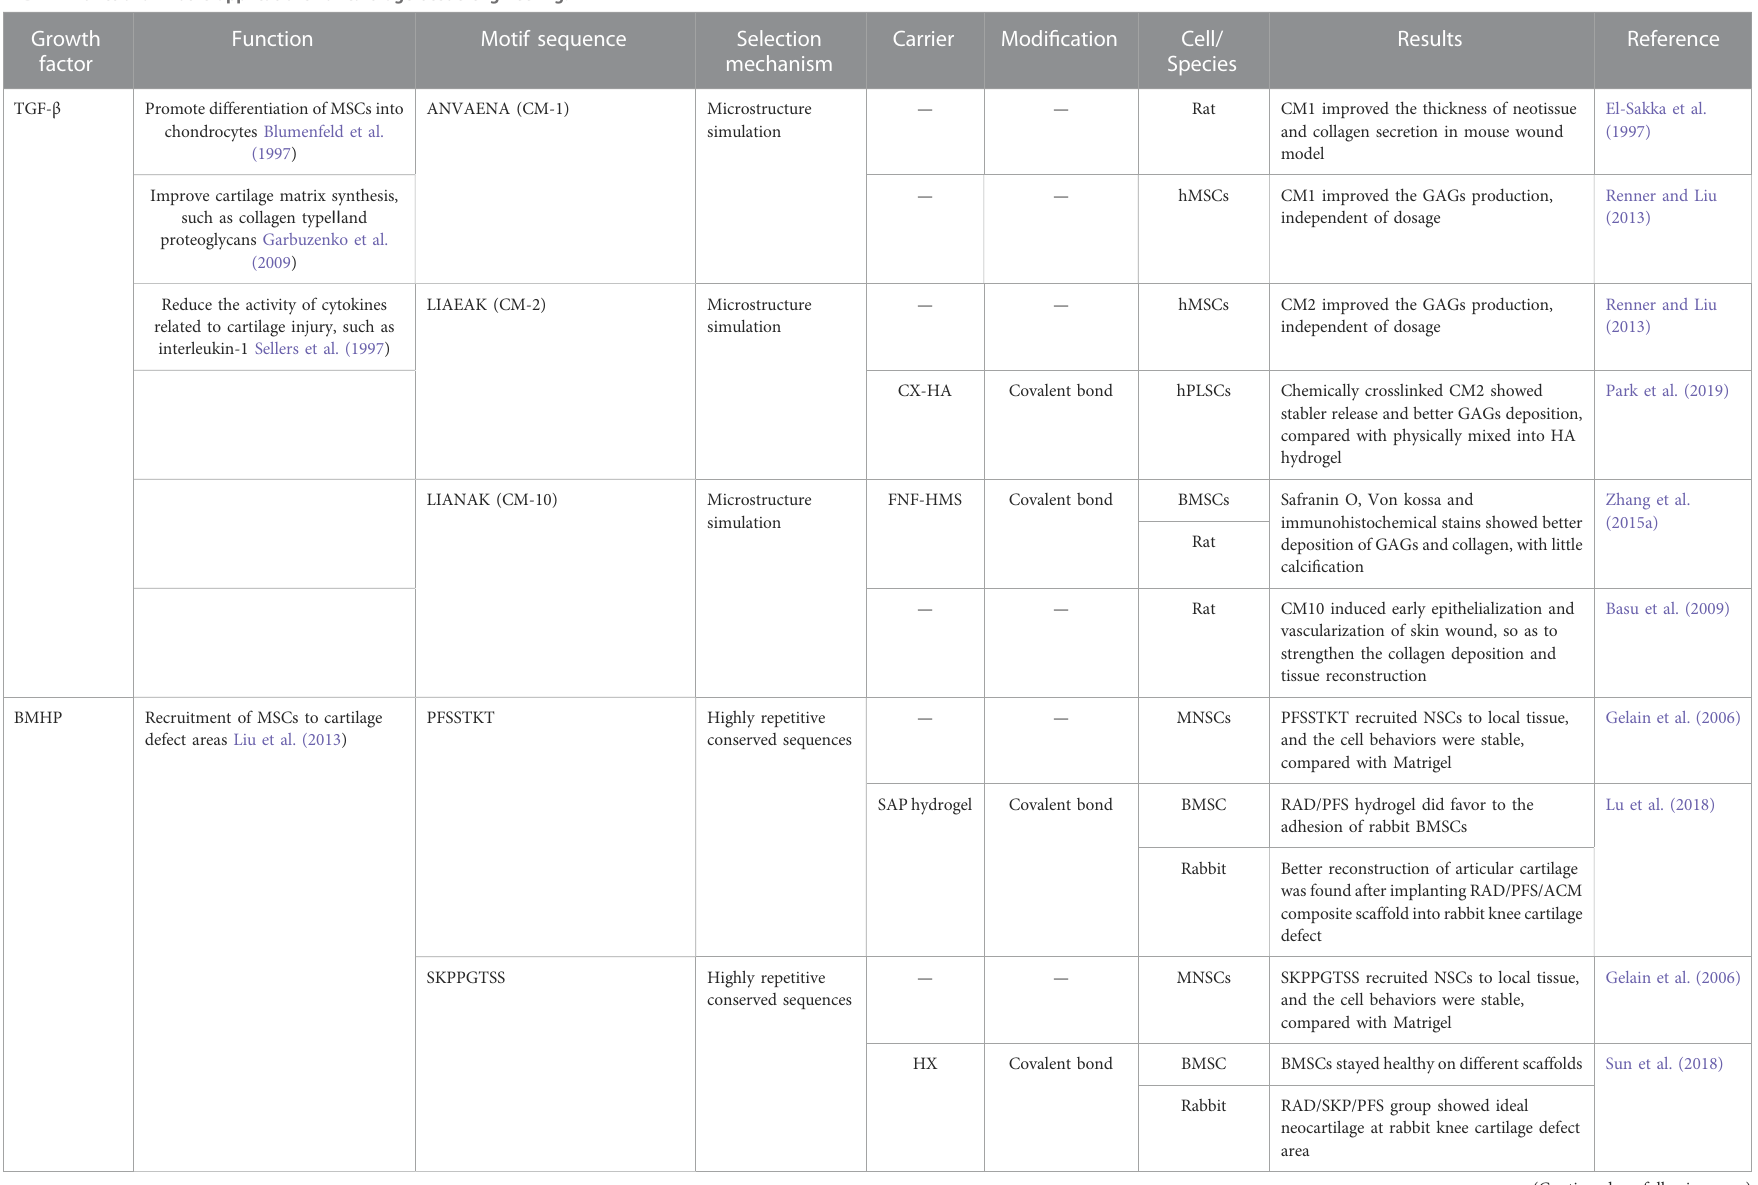
TABLE 1 Functional motifs applications for cartilage tissue